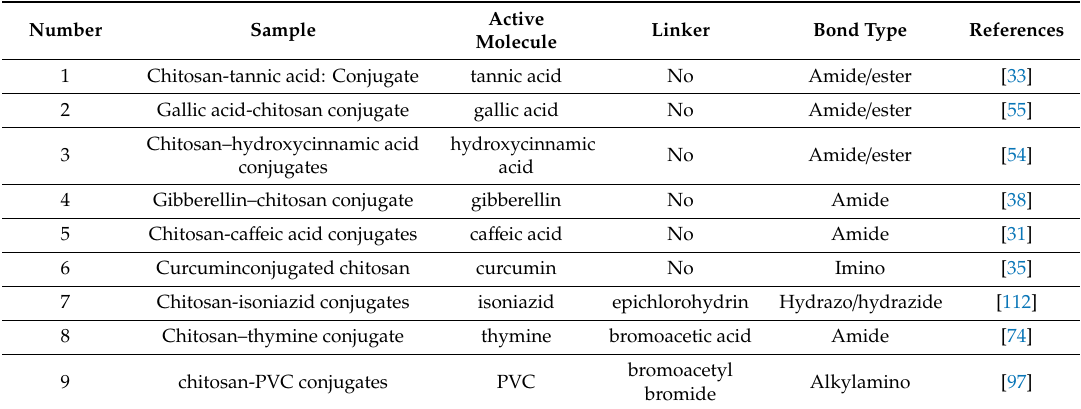
Table 1. Representative chitosan conjugate